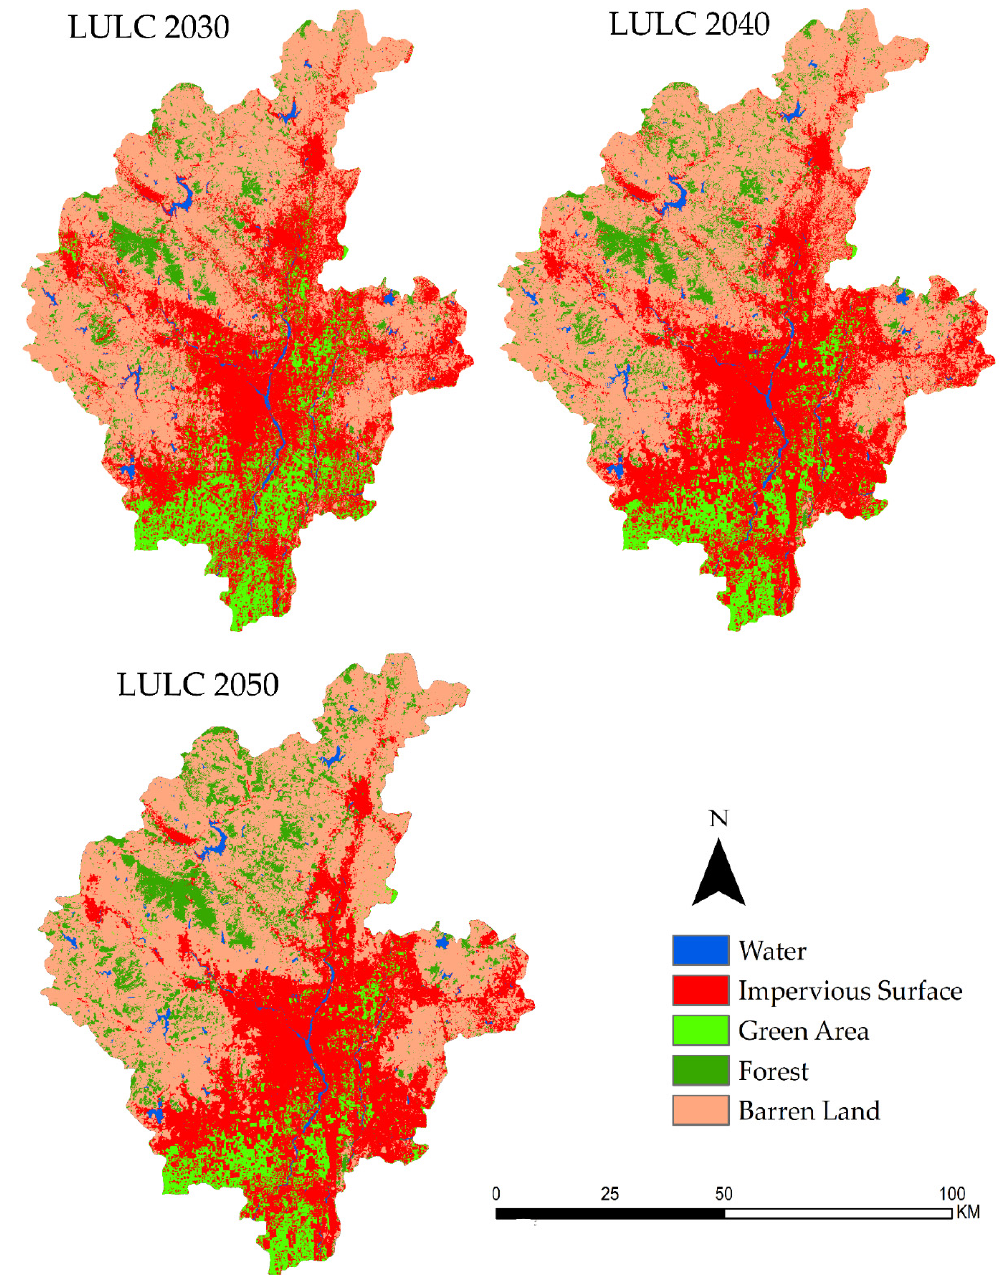
Figure 10. LULC prediction 2030–2050.